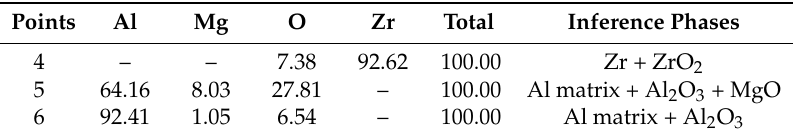
Figure 5. Representative microstructures of the Al/Zr/Mg joint: ( a ) overview of the stir zone (SZ), ( b , c ) magnified views of the R4 and R5, respectively, and ( d ) EDS line-scan results of the R4. Table 3. Elemental compositions (in wt.%) at points 4–6 in Figure 5b.